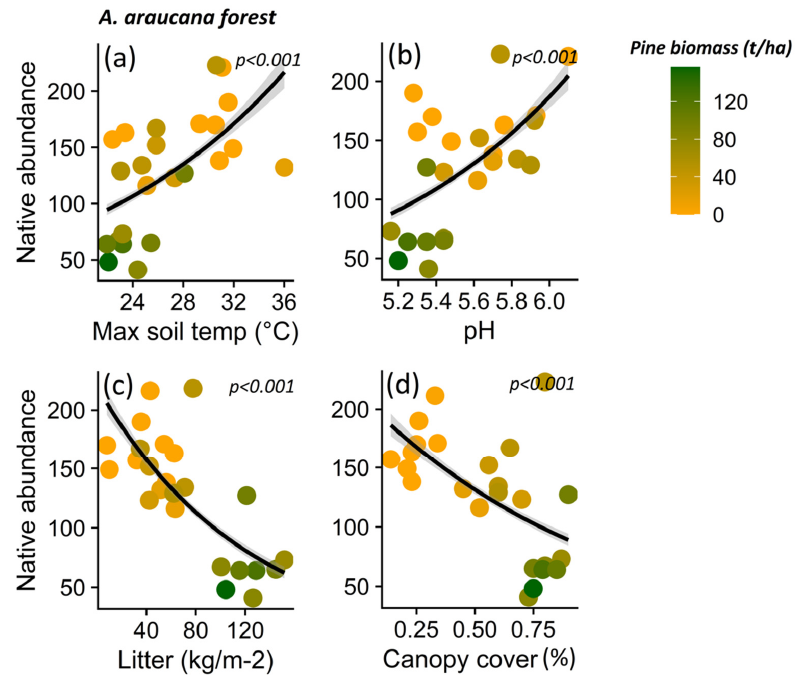
Figure 7. Relationship between native plant species, total abundance and maximum soil temperature ( a ), pH ( b ), litter content ( c ), and canopy cover ( d ) for Araucaria araucana forest. The lines show the linear model fit and the 95% confidence interval, and the color gradient at the points corresponds to the biomass gradient of Pinus contorta for the Araucaria araucana forest.